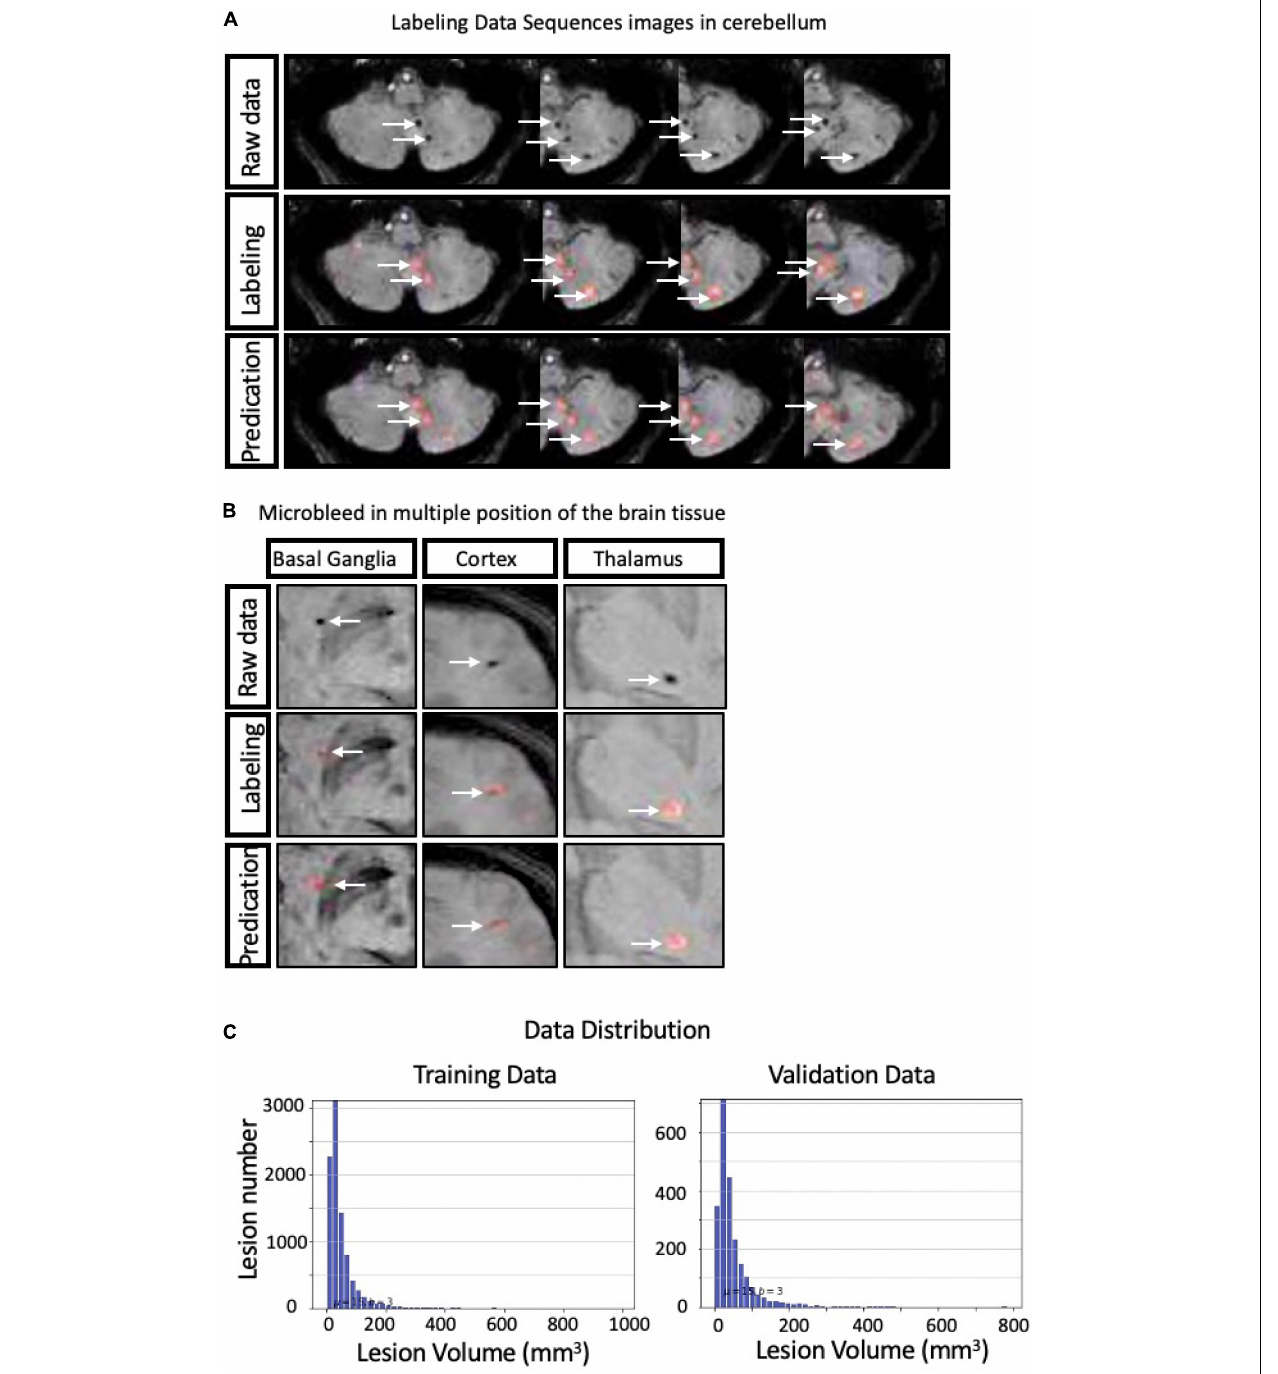
FIGURE 4 | Representative cases of manual cerebral microbleeding (CMB) labeling and labeling with the deep learning system (DLS) system (A,B) along with the data distribution (C) .